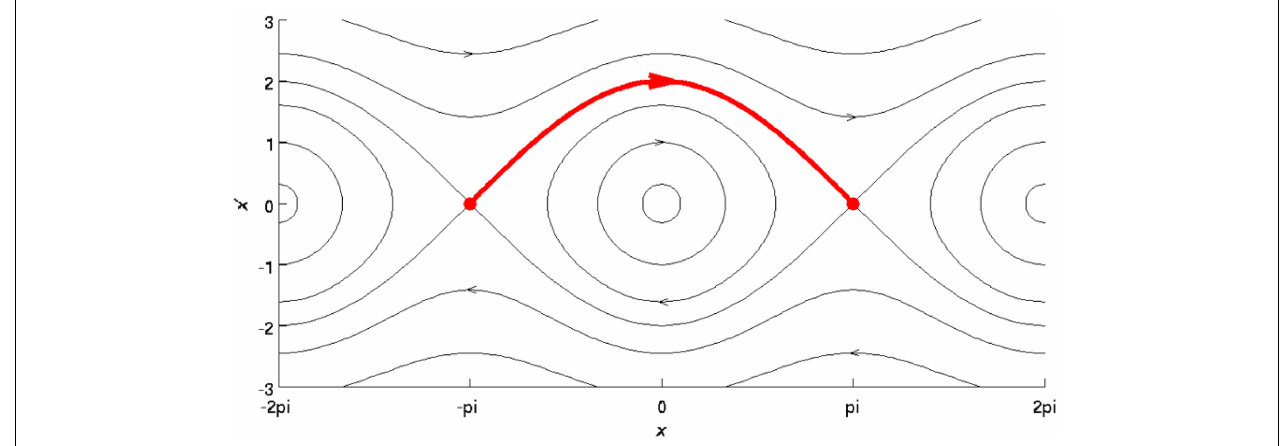
FIGURE 1 | Reprinted from Wikipedia (CC): A SHC is a set in the phase space of a dynamical system that consists of a circle of equilibrium points and connecting heterocyclic connections. In this image, the Y -axis indicates varying trajectories, and the X -axis indicates phase with respect to particular orbits, with the red arrow indicating the completion of one